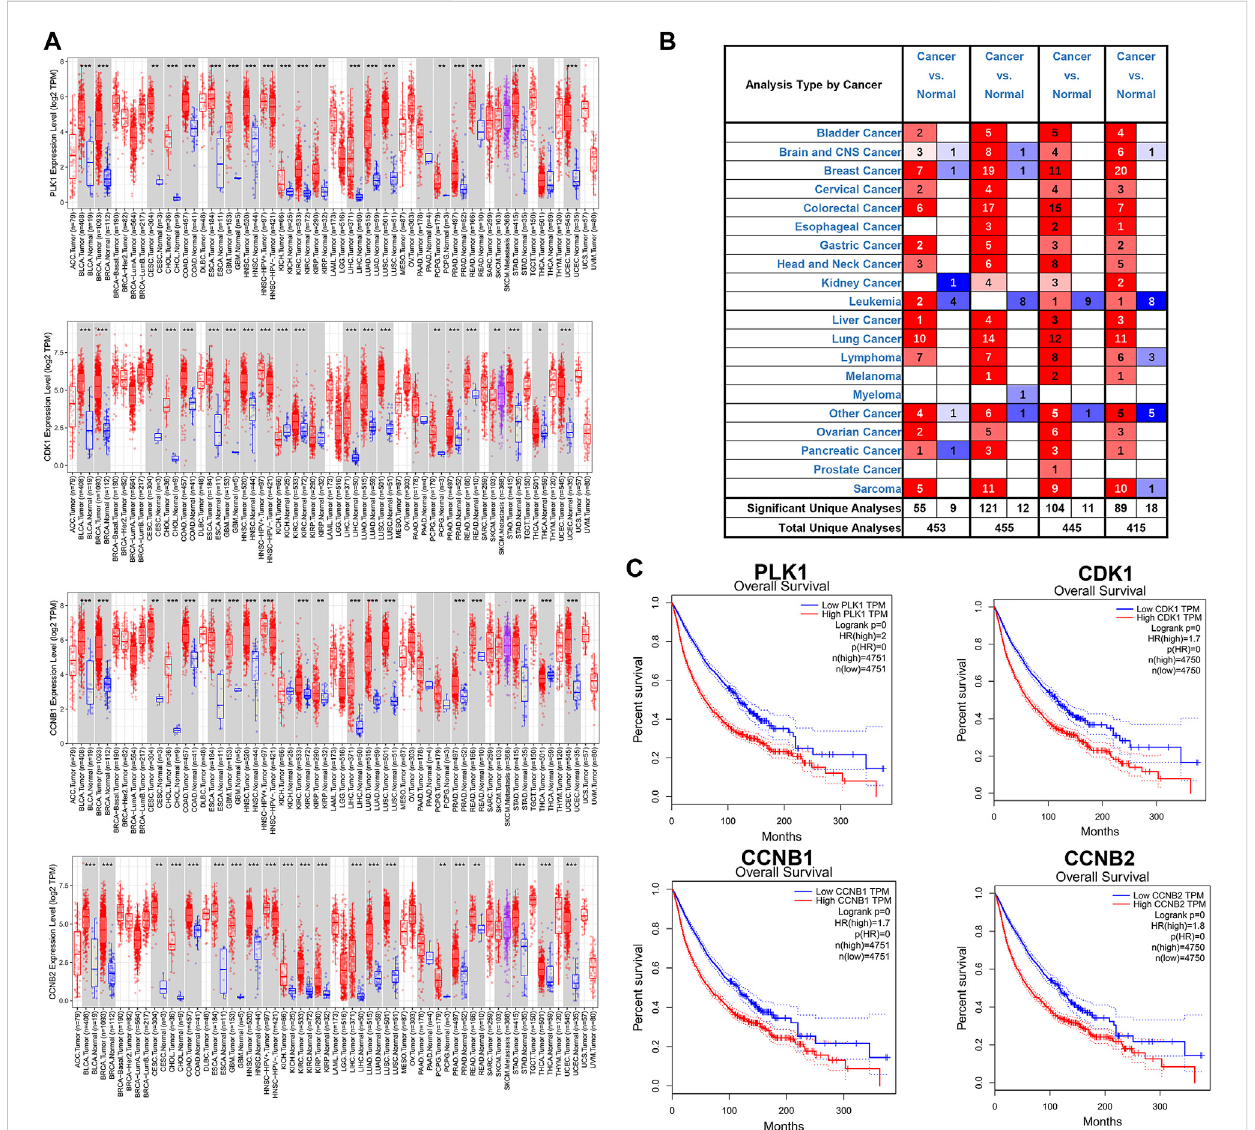
FIGURE 6 ExpressionsofhubgenesindifferentcancertypesfromTCGAandOncomine (A) mRNAexpressionlevelsofPLK1,CDK1,CCNB1,andCCNB2across various cancer types of TCGA dataset using Timer 2.0. The red box was the cancer sample, whereas the blue box was the normal sample. (B) mRNA expression levels of PLK1, CDK1, CCNB1,and CCNB2 indifferentcancertypesfrom theOncominedatabase.The number ineach unitwasthenumber of data sets. Upregulation was marked in red, and downregulation was blue. p -value, 10 − 4 ; fold change, two; gene ranking 10%. (C) The association of PLK1, CDK1, CCNB1, and CCNB2 with overall survival in all cancer types in GEPIA. TPM, Transcripts per Million. The plots were achieved using the GEPIA web server. Data are presented as the hazard ratio with a 95% con fi dence